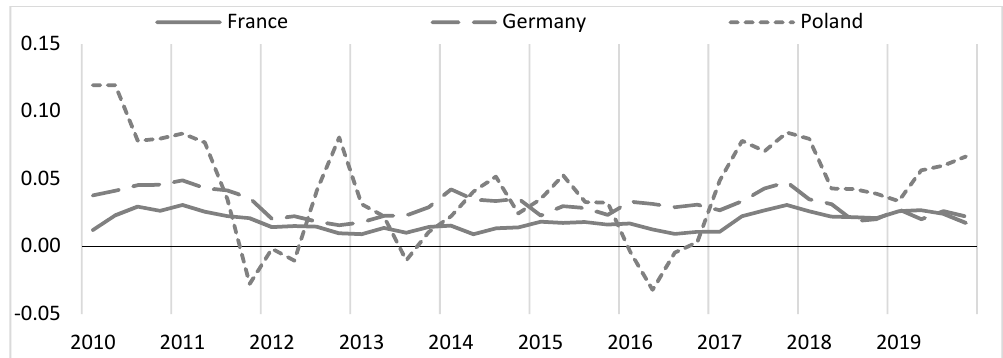
Figure 9. Growth rate of gross value added in relation to 𝐺𝐷𝑃 , own work, source: Eurostat.